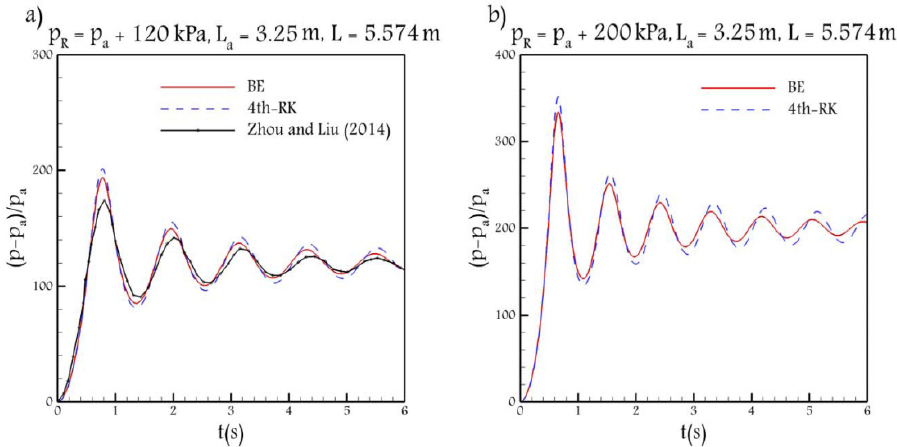
Figure 7. The non-dimensional air gauge pressure (p − p (cid:2911) ) p (cid:2911) ⁄ distribution vs. the time, calculated by both backward Euler scheme, and classical 4th order Runge–Kutta scheme, ( a ) for a test case of [21], p (cid:2902) = p (cid:2911) + 120 kPa and ( b ) p (cid:2902) = p (cid:2911) + 200 kPa .